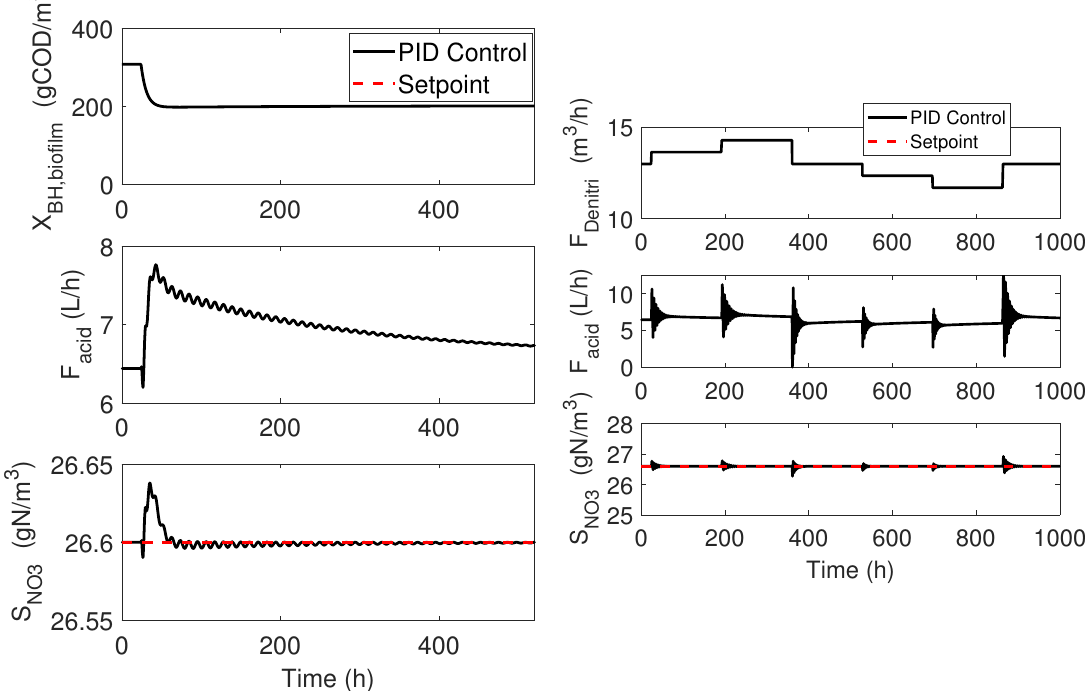
Figure 9. Closed-loop system input/output evolutions following ( left ) an increase in biomass decay rate from 2.6 10 2 to 7.8 10 − 2 h − 1 and ( right ) 5 to 10% step variations applied to the bypass × × flowrate ( F Denitri